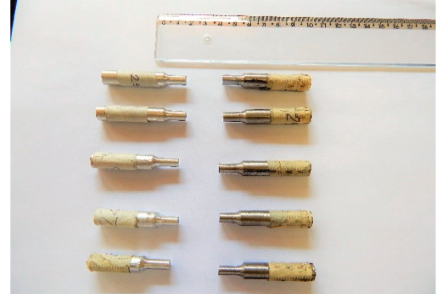
Figure 8: Specimens ruptured after the tensile test.